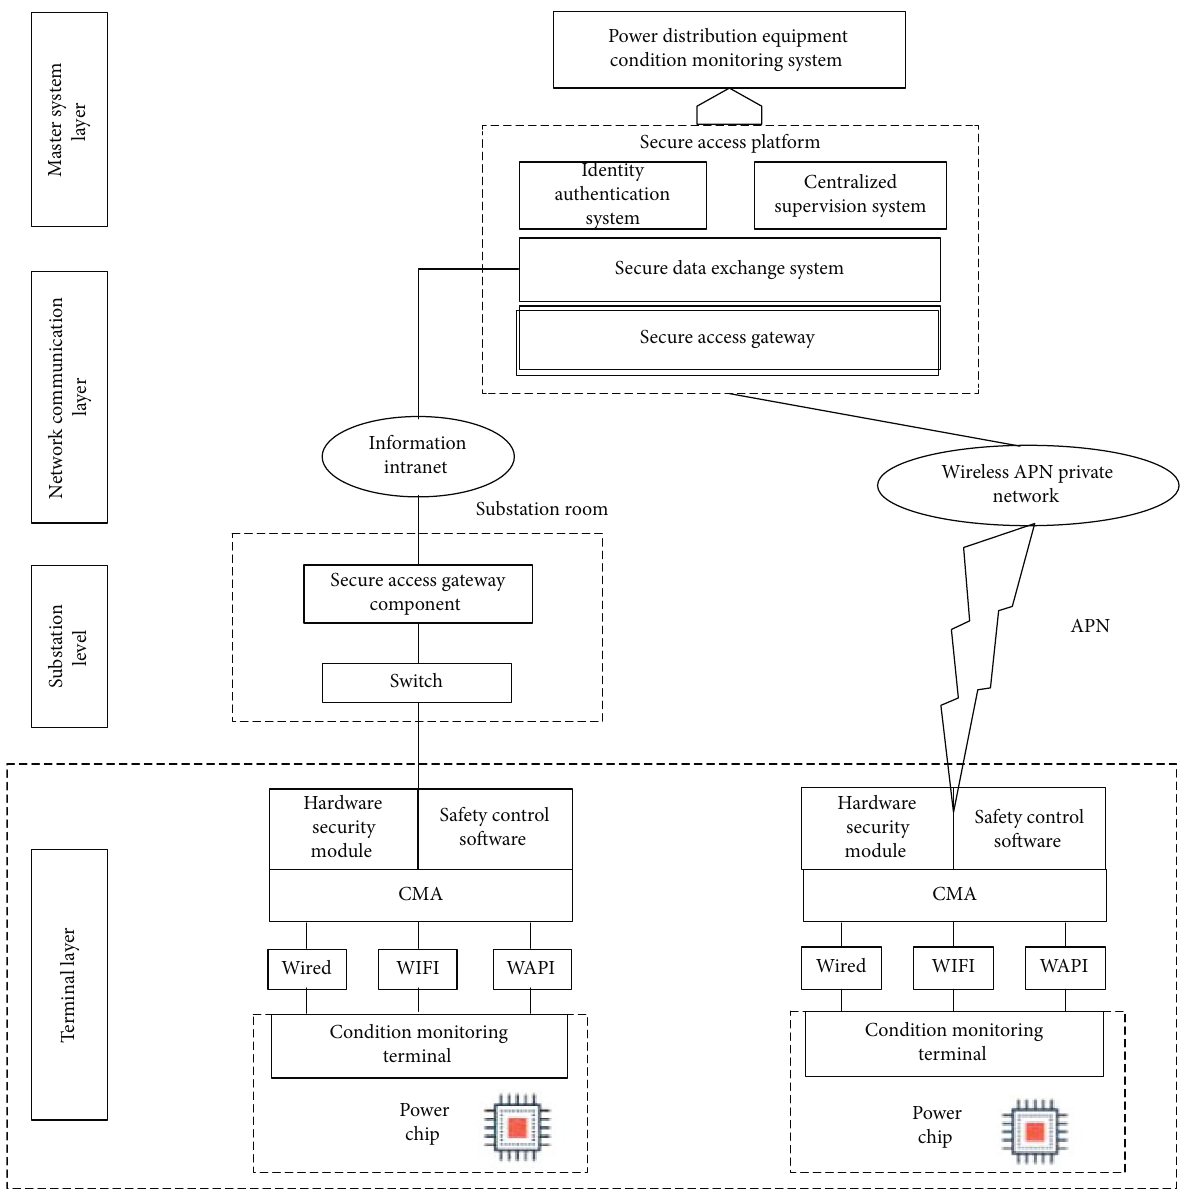
Figure 5: Architecture diagram of the environmental monitoring system for electrical equipment based on power